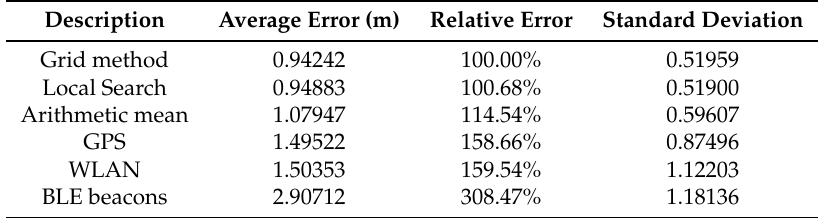
Table 2. Accuracy of aggregation of all location methods: GPS, WLAN, and BLE.